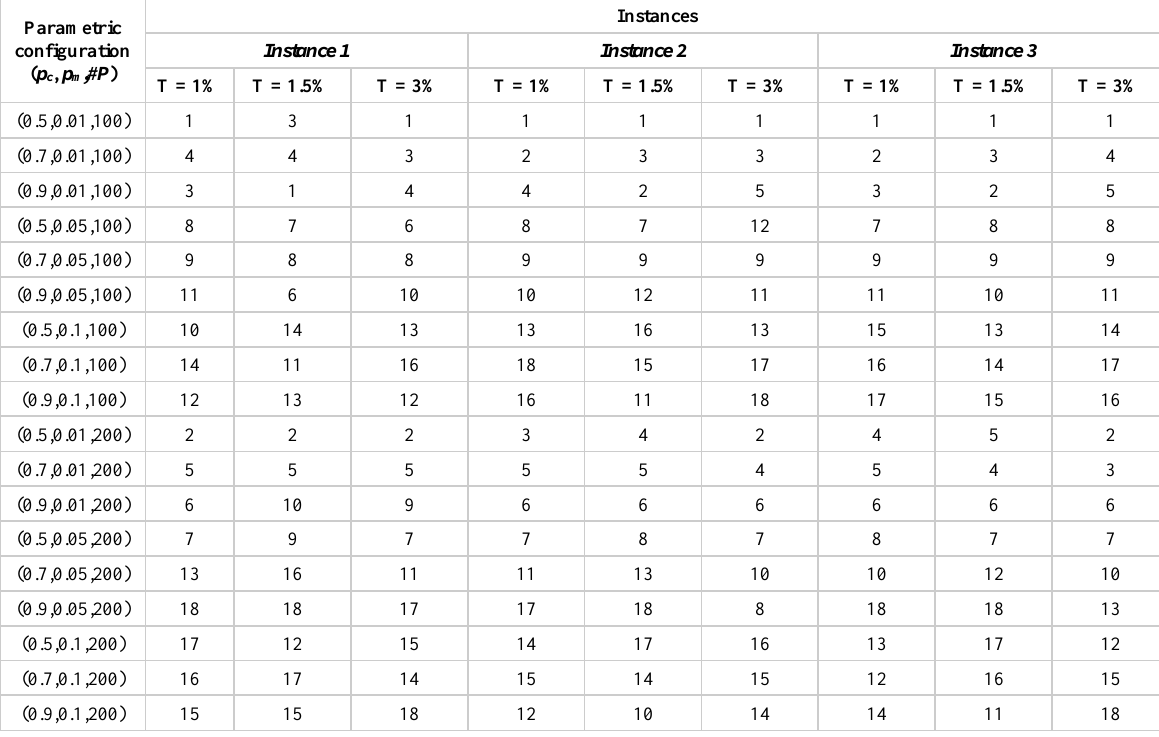
Table 1 . Parametric setting of the MOEA/Ds using the Friedman rank test. Parametric